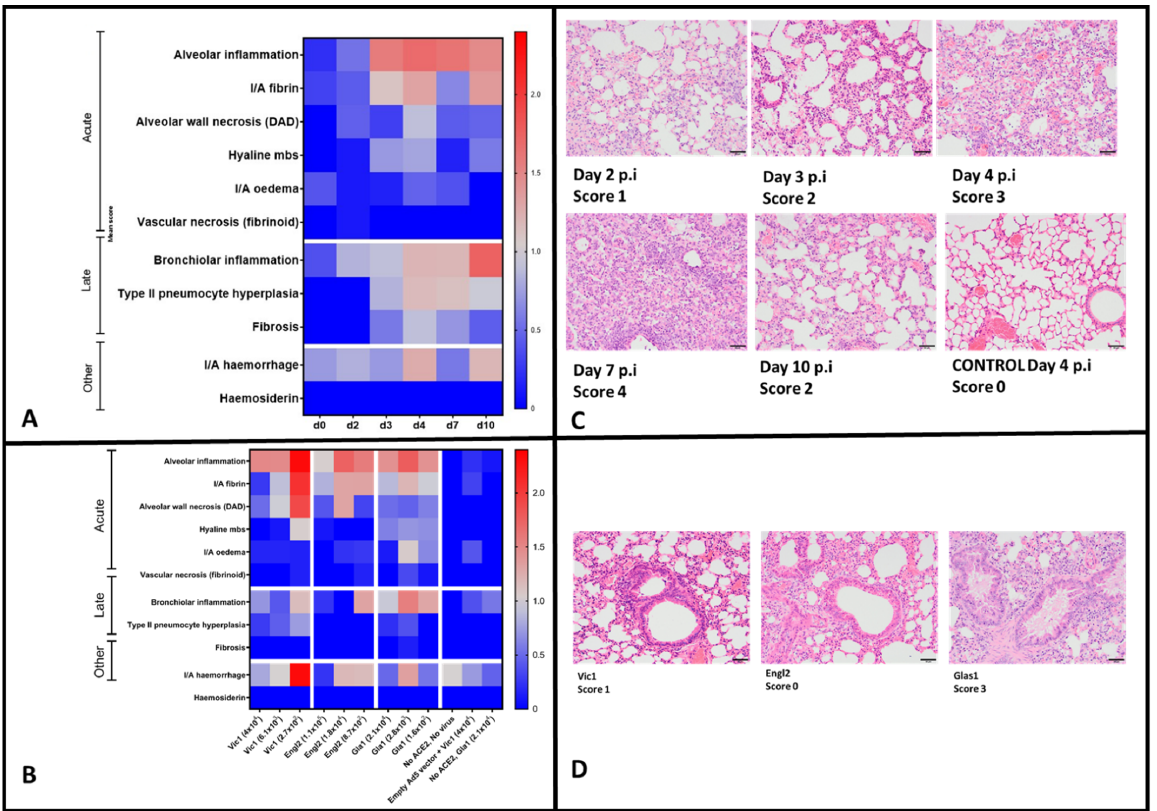
Figure 5. Histopathology in lungs from mice infected with SARS-CoV-2. For all mice, lungs were scored based on the histopathological criteria indicated. The mean group score multiplied by the percentage of tissue affected was determined and is shown as a heat map ranging from low (blue) to higher values (red). (A) Groups of five mice were transduced with Ad5hACE2 and five days later infected with a single dose of SARS-CoV-2 Vic1. Mice were humanely killed on different days (0, 2, 3, 4, 7 and 10), as indicated on the x -axis and lungs collected in formalin for histological analysis. (B) Groups of five or six transduced mice were infected with the indicated dose of SARS-CoV-2 Vic1, Engl2 or Gla1. Control mice were also treated as indicated. All mice were humanely killed on day 4 post infection and lungs were collected in formalin for histological analysis. (C) Groups of five transduced mice, challenged with 10 5 TCID 50 SARS-CoV-2 Vic1, were humanely killed at days 2–10 post infection (p.i.), with lung histopathology examples of haematoxylin and eosin staining. (D) A comparison of the bronchiolar inflammation which had developed by day 4 p.i. in mice infected with 10 4 TCID 50 SARS- CoV-2 Vic1, Engl2 or Gla1 was carried out, showing that Gla1 induced more severe inflammation than Vic1 or Engl2. For c and d Images at ×200; bar = 50 µm. All other indicators of acute inflammatory response remained low throughout, with the exception of fibrin, which was at higher levels on days 4 and 10 p.i. (Figure 5A). Haem- orrhage was also more abundant at these time-points (Figure 5A). In terms of late re- sponse, bronchiolar inflammation increased over time, leading to the highest score on day 10 p.i. and Type II pneumocyte hyperplasia also appeared at later time-points (days 4 and 7) (Figure 5A). When looking at the histological features of the lungs of mice infected with different doses and variants of SARS-CoV-2, there was no clear dose-related pattern (Figure 5C). After infection with SARS-CoV-2 Vic1, lung features, particularly those associated with an acute response and haemorrhage, were paradoxically the highest in the mice receiving the lowest dose of the virus (Figure 5C). However, bronchiolar inflammation was high at each dose in mice infected with SARS-CoV-2 Gla1 compared with those infected with SARS-CoV-2 Engl2 and SARS-CoV-2 Vic1 (Figure 5C,D).